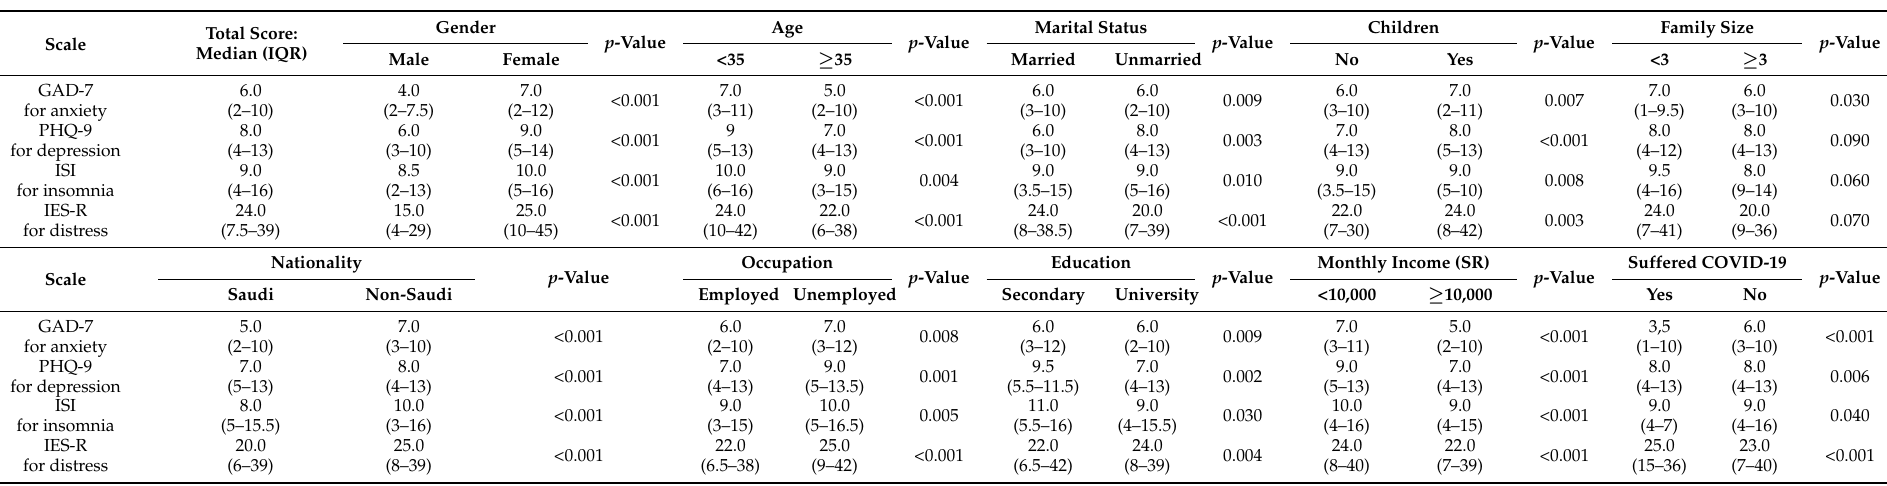
Table 3. Total scores of the studied health outcomes in the general population and among different